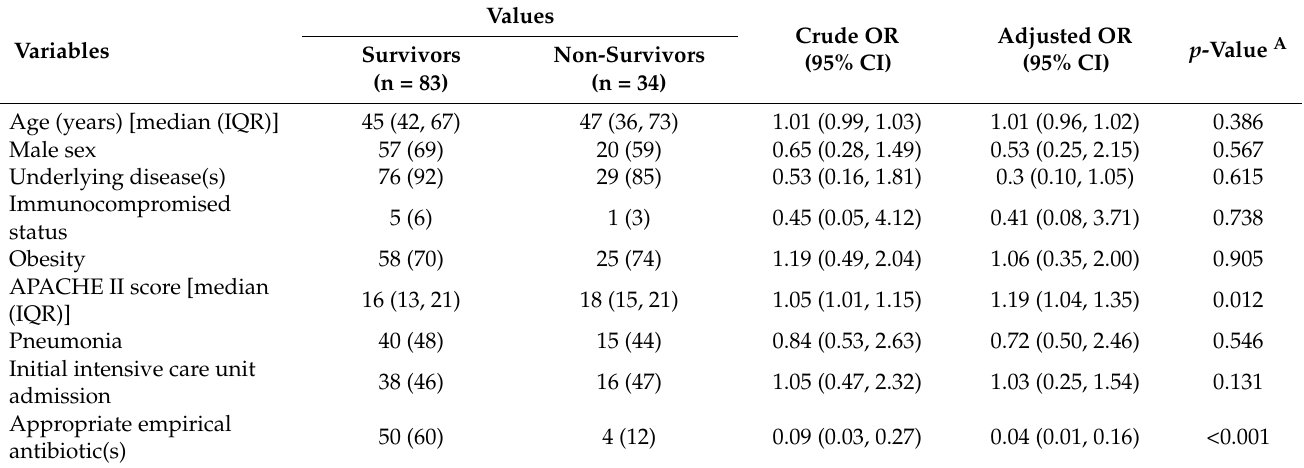
Table 4. Factors associated with 30-day mortality in 117 S. maltophilia bacteremia